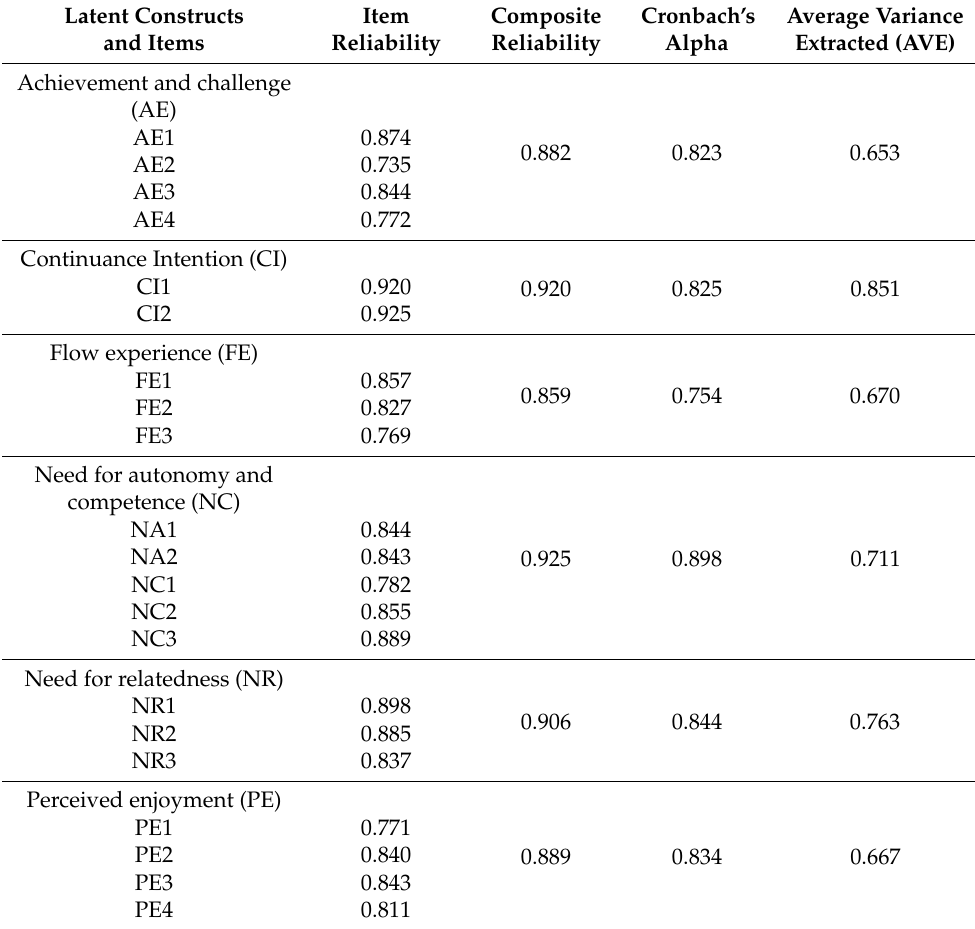
Table 2. Item loadings and measurement